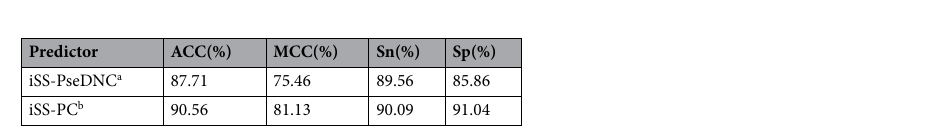
Table 3. The comparison of the 5-fold cross-validation test results on benchmark data-set only containing splice donor site sequences. a The prediction method developed by Wei Chen (2014). b The prediction method proposed in this paper.